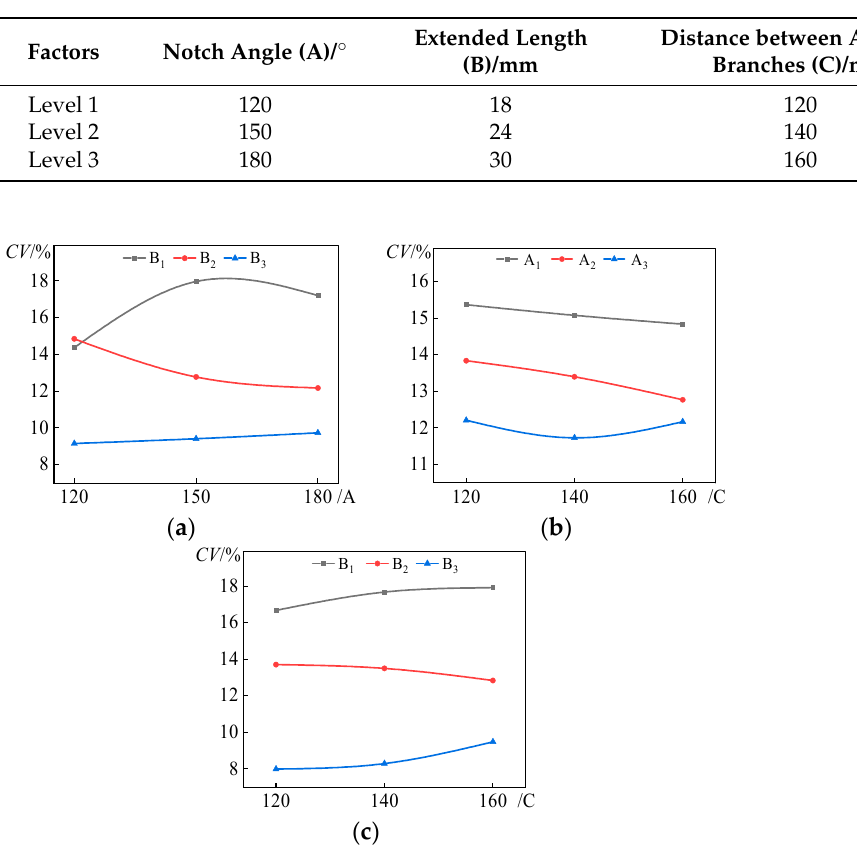
Figure 4. Analysis of two-factor interactions between the three factors: ( a ) Factors A and B; ( b ) Factors A and C; ( c ) Factors B and C. Y axis represents the coefficient of variation of consistency of sectional gas velocities in different rows. Table 1. Experimental factors and levels for orthogonal test.